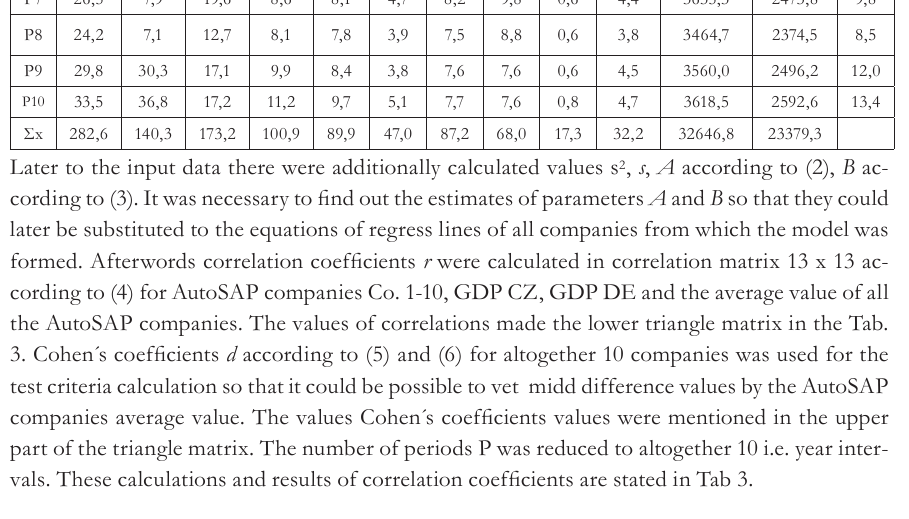
Tab. 3 – Correlation and Cohenś Coefficients Co. Sales vs CZ GDP. Source: own